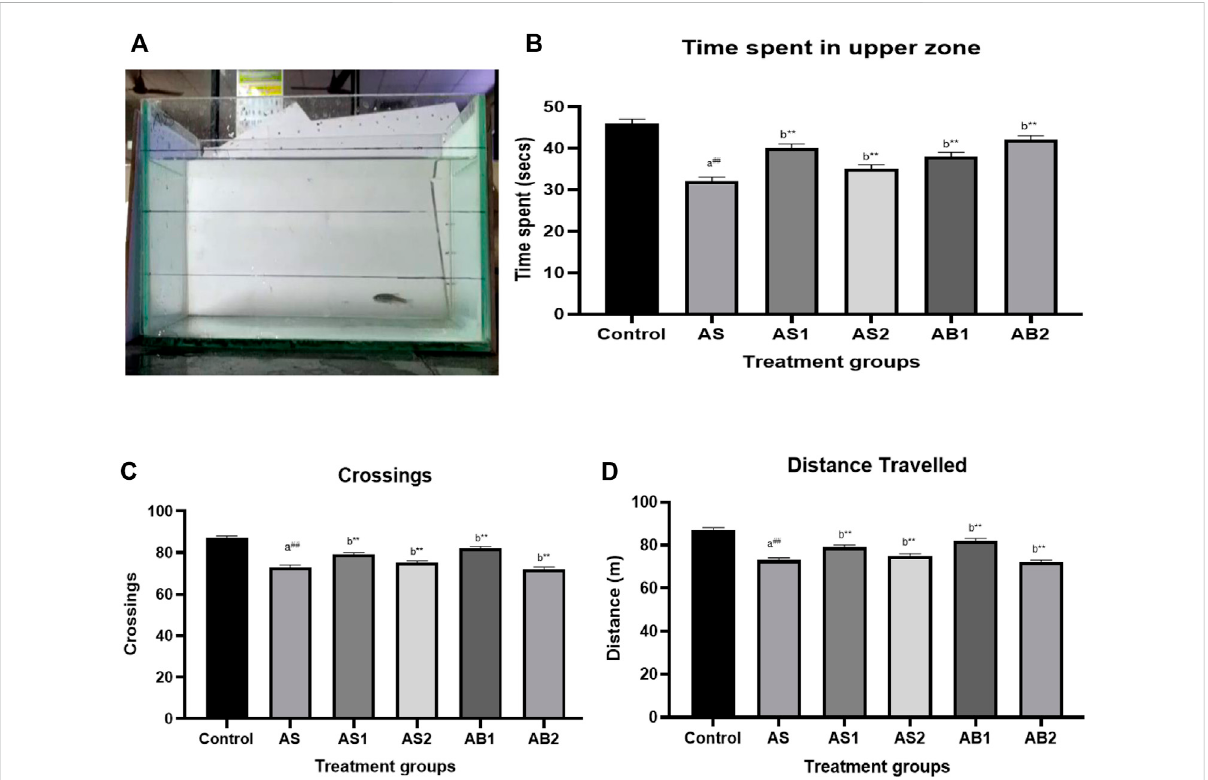
FIGURE 6 (A) Novel tank test of drug-treated group showing the exploratory behaviour of zebra fi sh (AS) (B) The effect of treatment on time spent in the upper level of the tank in novel tank (AS) (C) The effect of treatment on crossing of zones in novel tank (AS) (D) The effect of treatment on total distance travelled in novel tank (AS). Values are presented as the mean ± S.E.M. A one-way ANOVA followed by Bonferroni post hoc test ( n = 8 – 10) was used. (A) Comparisons were made between the stressed group (AS) with the normal control. (B) Comparisons were made between AS1, AS2,AB1andAB2with thestressedgroup (AS).p-value***represents p < 0.001,**represents p < 0.01,*represents p < 0.05, ## represents p < 0.01. (B) shows the effects of Baicalein (AB1 andAB2), diazepam (AS1) and fl uoxetine (AS2) in zebra fi shes involved in the acute stress model. As expected, diazepam signi fi cantly decreased thetime spent inthebottom and increased thetime spent theupperzoneof thetank[panel (B) ].Baicalein-treated groups such as AB2 and AB2 signi fi cantly increase the time spent in the upper zone (38 and 42 s respectively). The distance travelled [panel (D) ], the number of crossings [panel (C) ] and entries to the bottom area was not affected by any